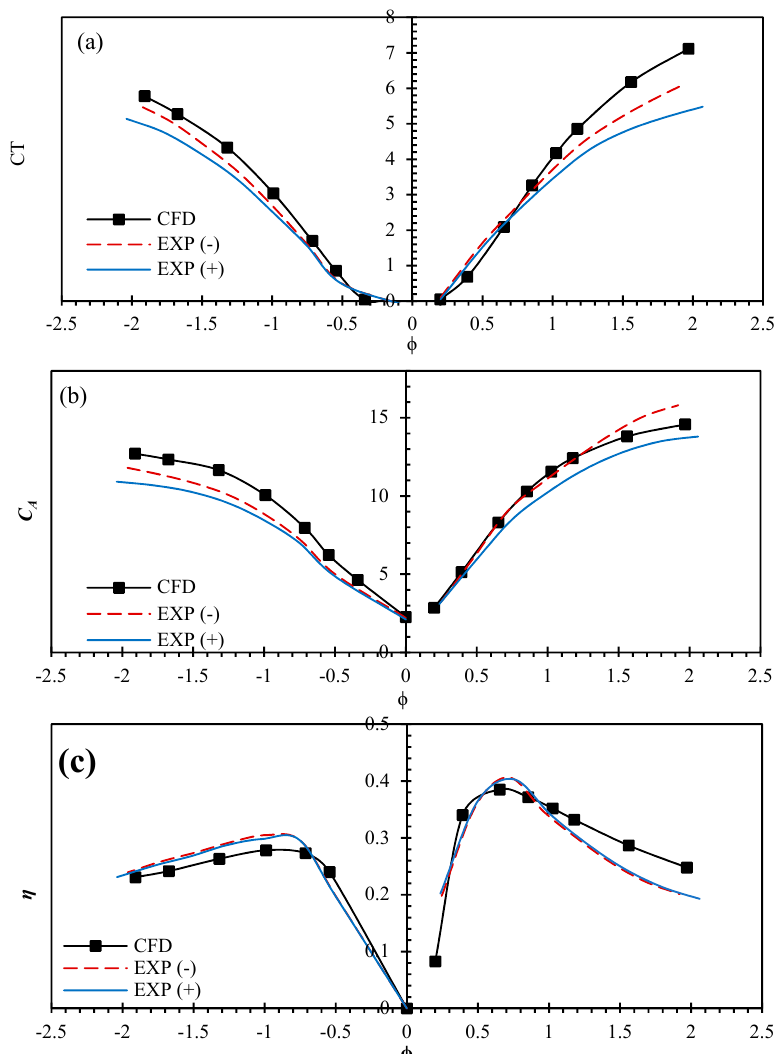
C , ( b ) C and ( c ) η . (Horizontal axis: flow T A